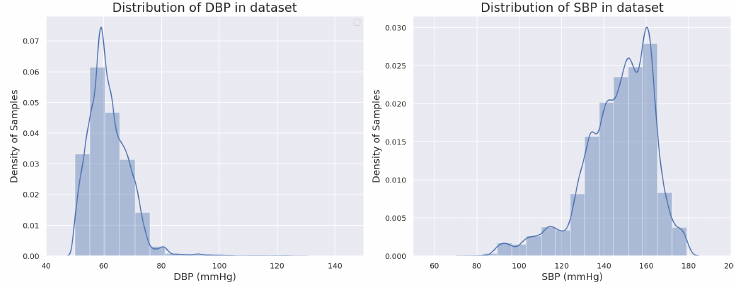
Figure 1. Distribution of BP in the